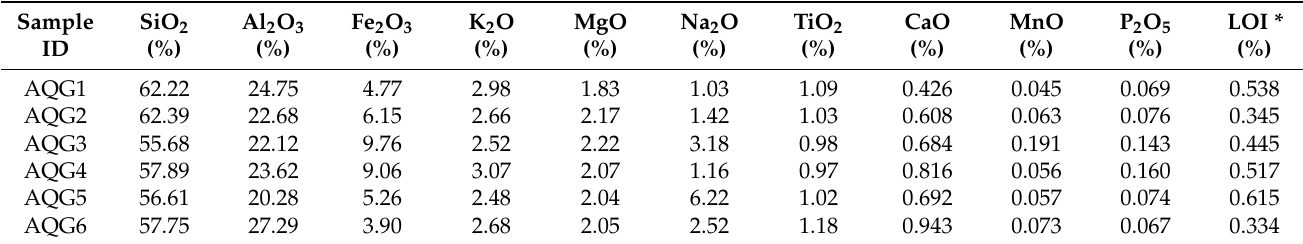
Table 1. Relative content of the major elements and loss on ignition results of the samples.